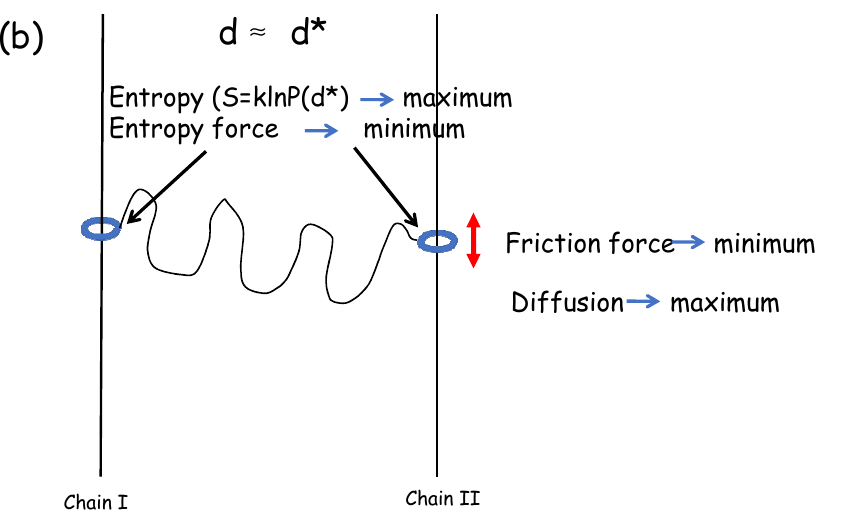
Figure 6. ( a ) Probability distribution function P(r) of end-to-end distance r for a single 100-monomer flexible polymer chain. Here the maximum value of P(r) is located at r* = 16.5. ( b ) A schematic illustration of two ring chains sliding along the symmetric axial chains fastest at d = d* = r* owing to the fact that the conformational entropy of the linking chain between two ring chains approaches is close to the maximum value, and the entropy force approaches to the minimum one at d = d*.